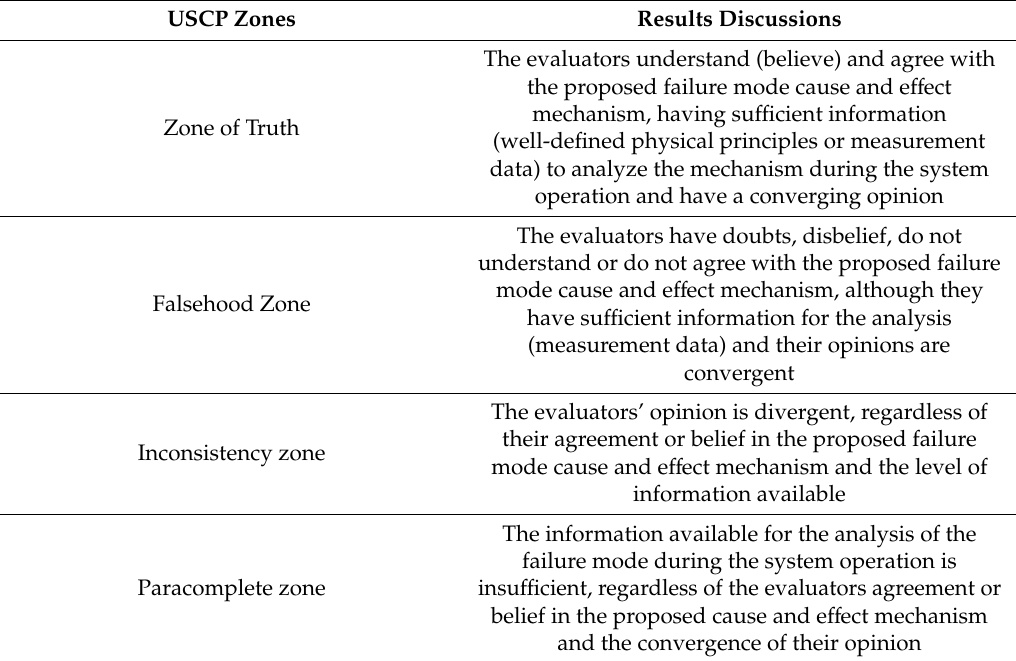
Table 16. Results discussion regarding Unitary Square on the Cartesian Plane (USCP)